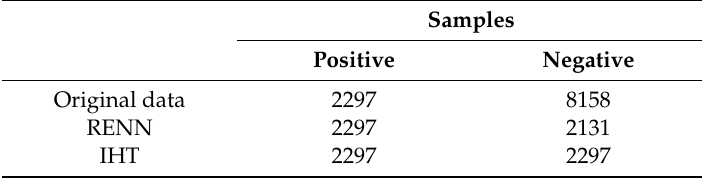
Table 1. Sample numbers within the original and re-balance datasets.